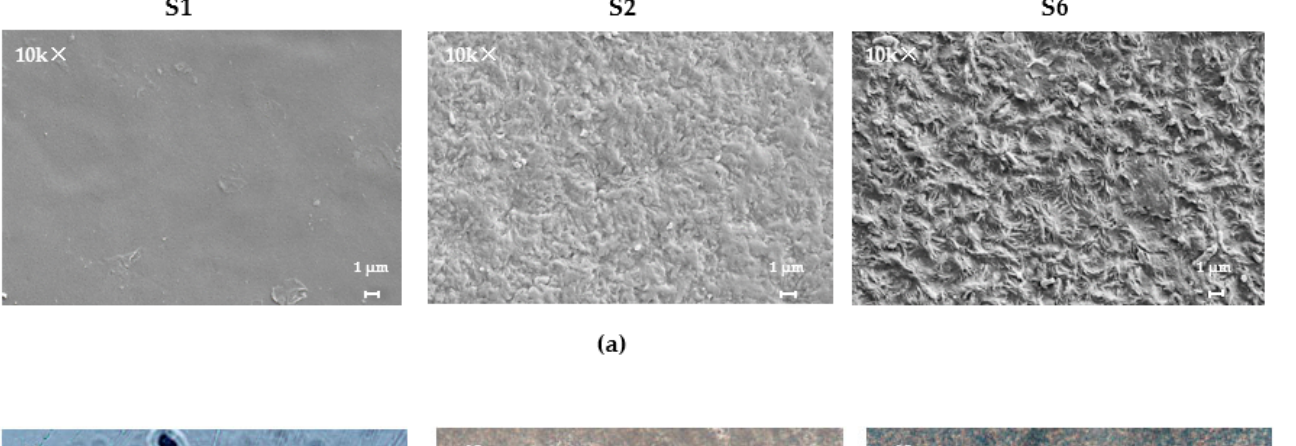
Figure 10. SEM micrographs ( a ) and POM images ( b ) of segmented PUU of the compositions S1, S2, and S6.